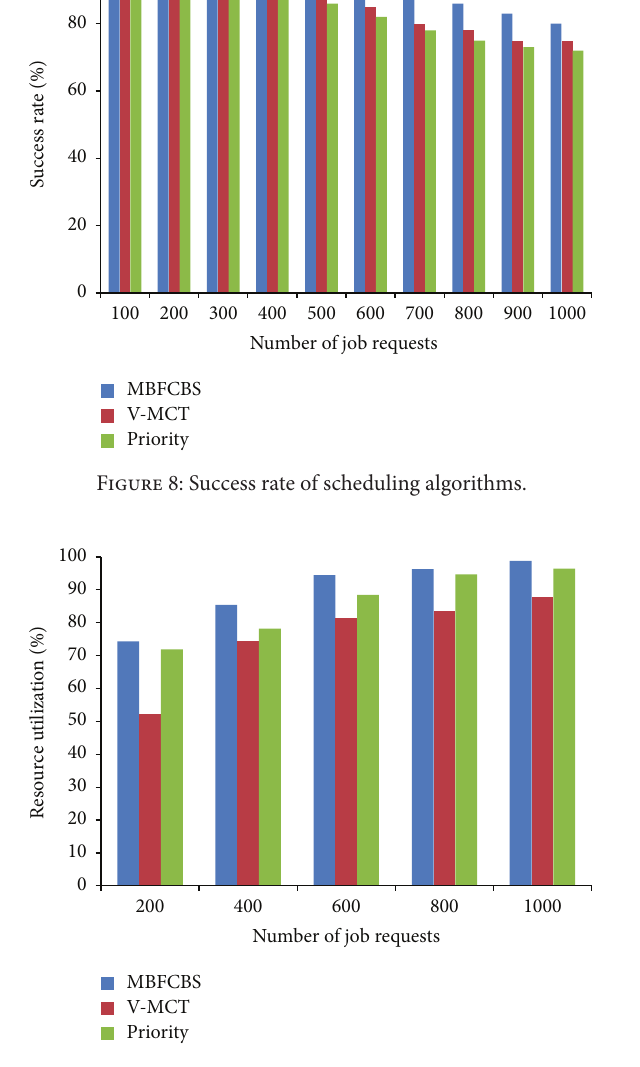
Figure 9: Resource utilization in percentage.